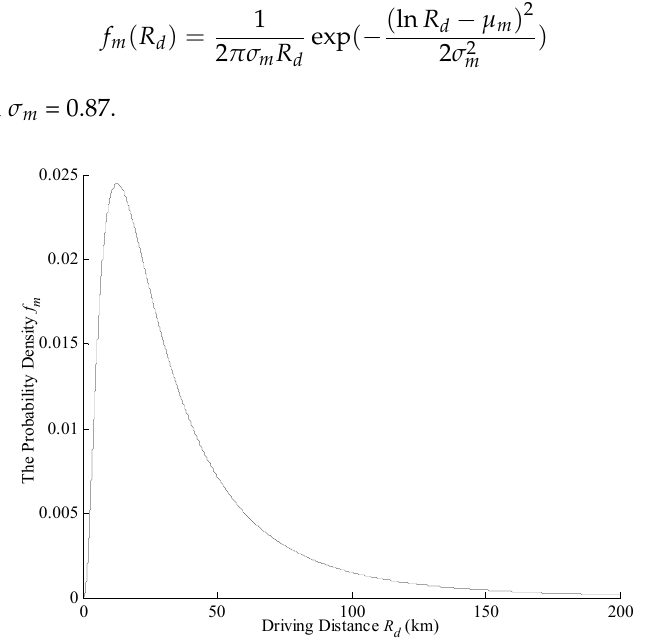
Figure 2. Lognormal distribution of the daily driving distance of the EV.